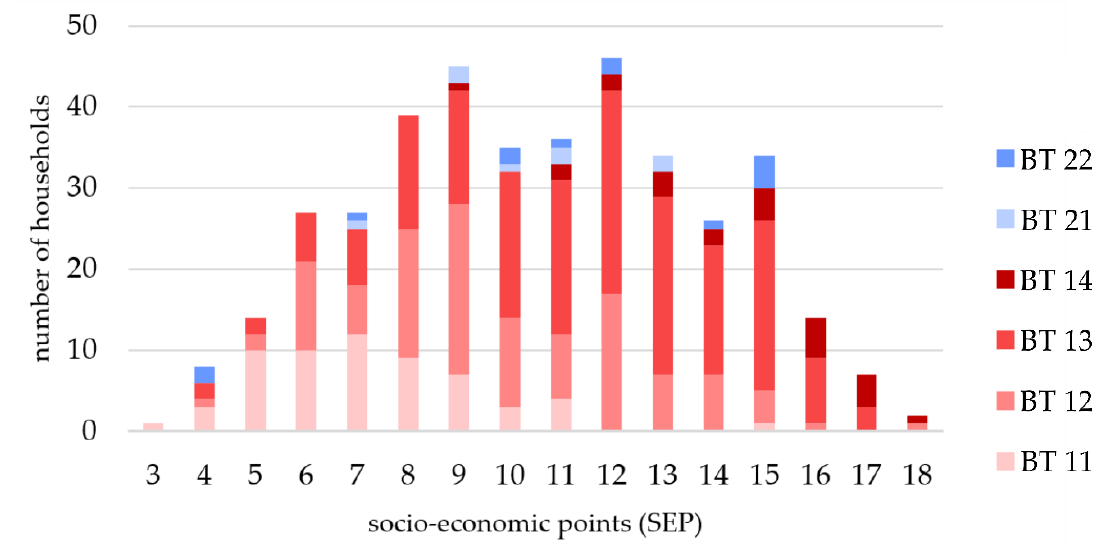
Figure 9. Histogram showing the statistical distribution of residential socio-economic points on household level in Belmopan. Data based on interviews.